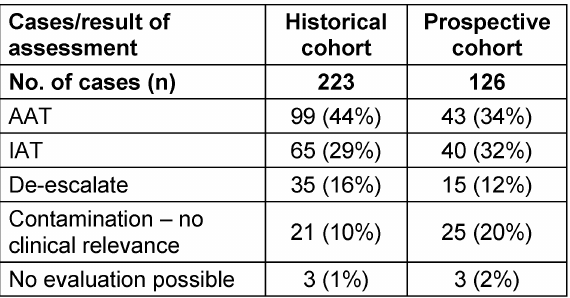
The group of patients with IAT (per-protocol population) were assessed by direct comparison. First the baseline characteristics were analysed to make sure that no